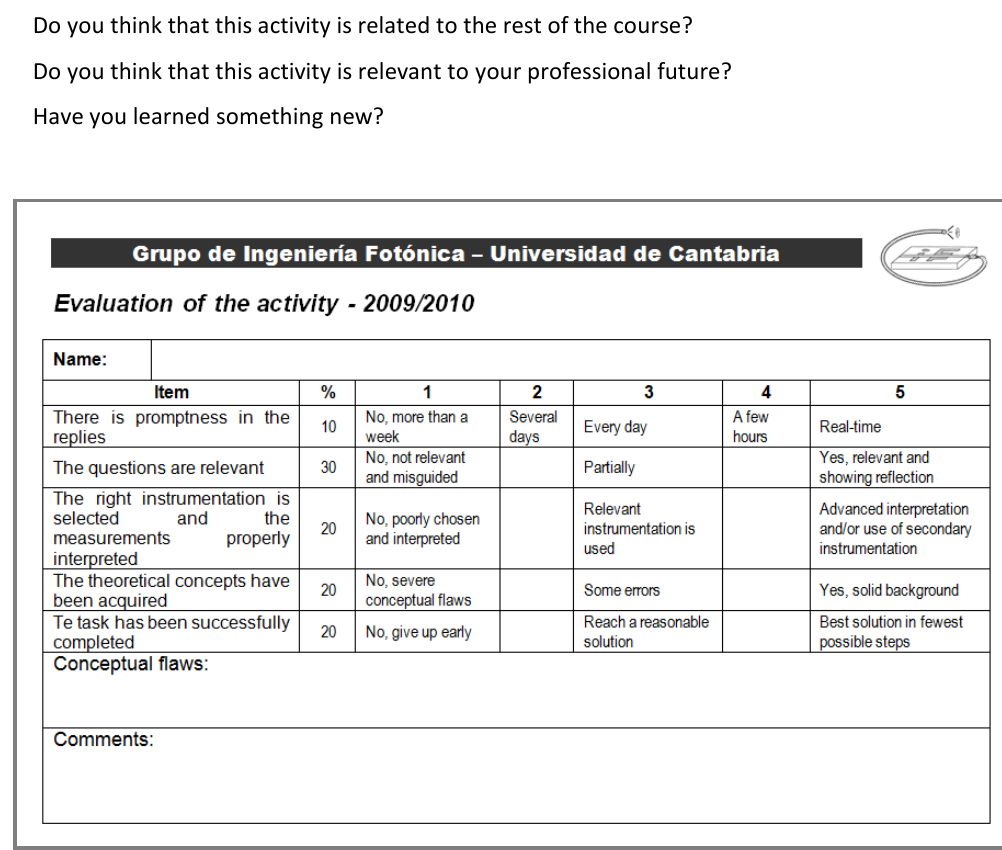
Fig. 2.: Rubric for the evaluation of the